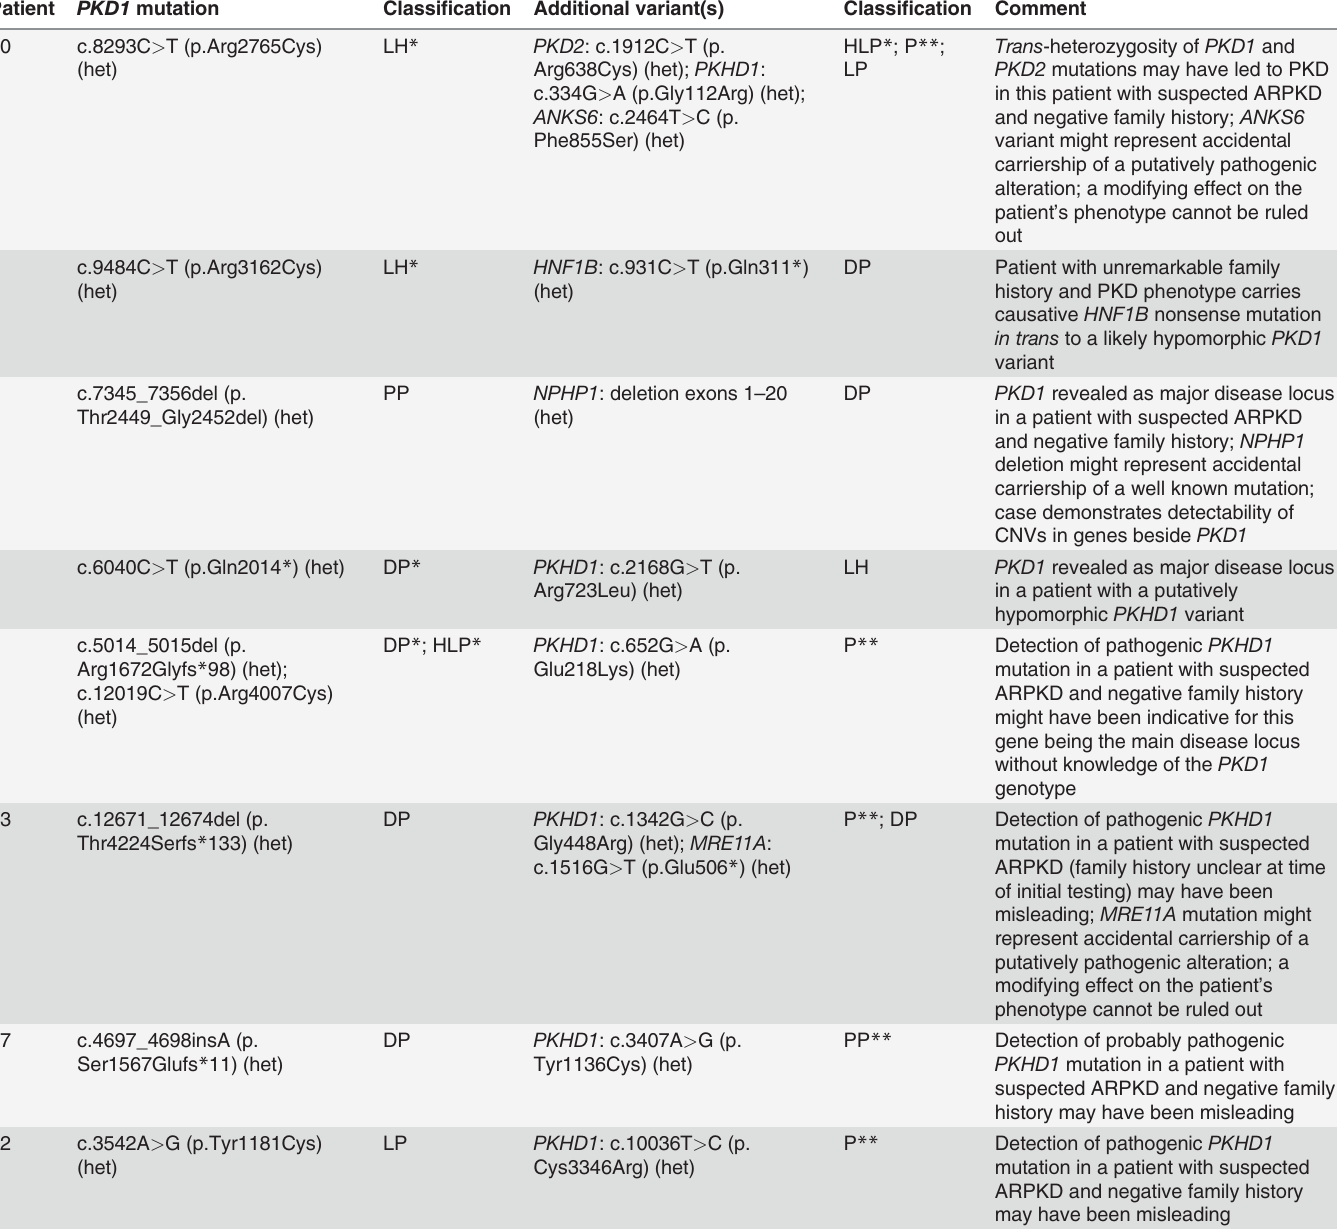
Table 2. Mutations and variants identi fi ed in other genes for cystic and polycystic kidney